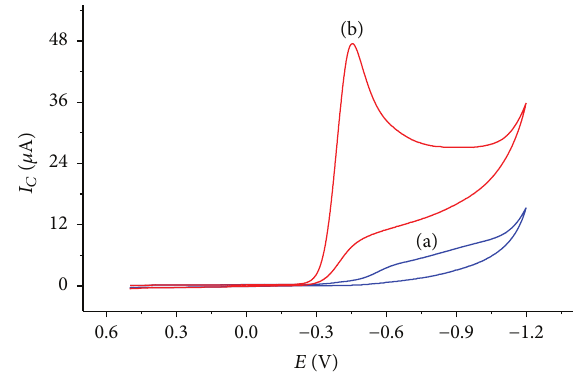
Figure1: Cyclicvoltammograms ofCPEinBRBsolutioncontaining (a) no MTZ and (b) 1mM MTZ at pH 2.0 and scan rate 100mV/s.